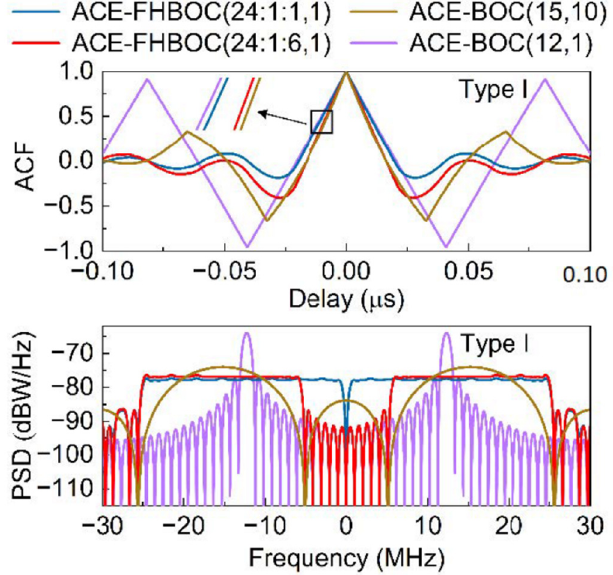
Figure 7. Normalized ACFs and PSDs of the Type-I example signals. The bottom panel of Figure 7 shows the normalized PSDs of the Type-I example signals. The power in the PSD main lobes is evenly distributed within the bands for the example signal. The PSD main lobes of ACE-BOC(12,1), ACE-BOC(15,10), and